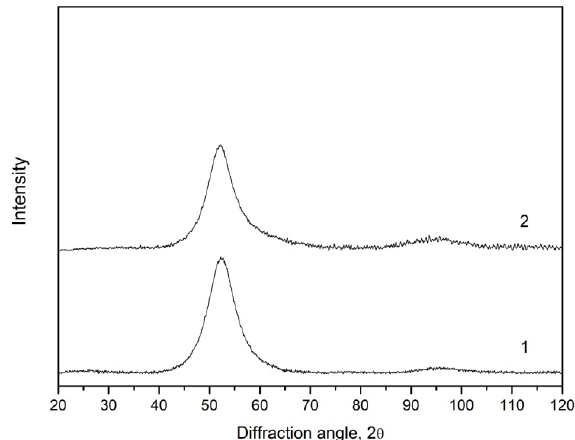
Figure 1. X-ray diffraction patterns of the initial amorphous Fe 73.8 Si 13 B 9.1 Cu 1 Nb 3.1 ribbons ( 1 ) and microwires ( 2 ).